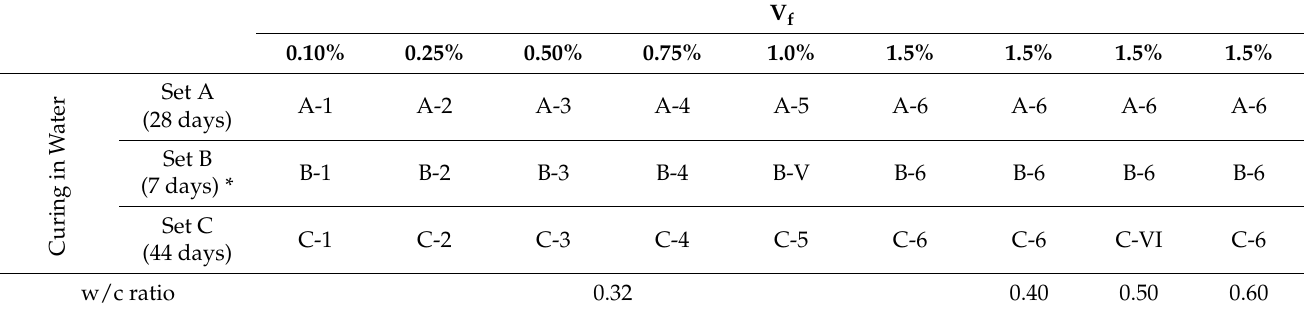
Table 3. Outline of experimental